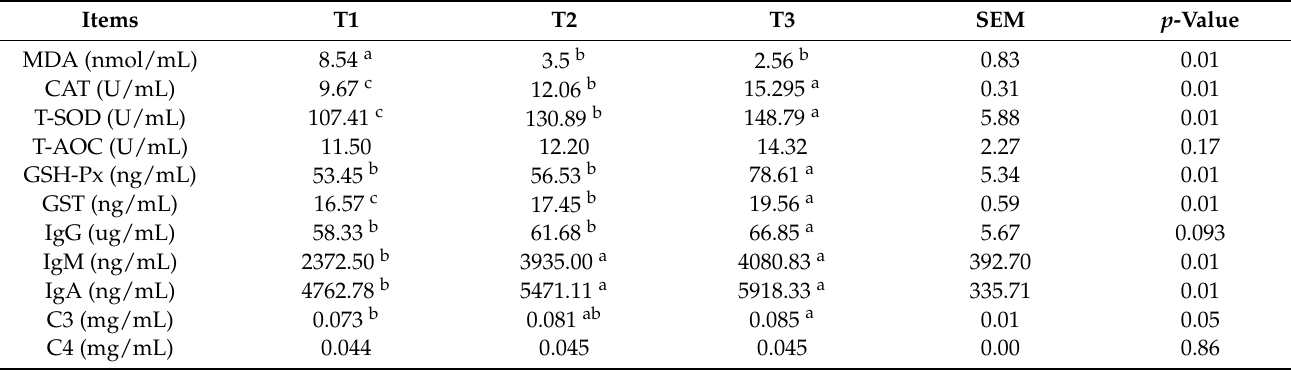
Table 4. Effects of fructooligosaccharides on antioxidant and immune response of laying hens.